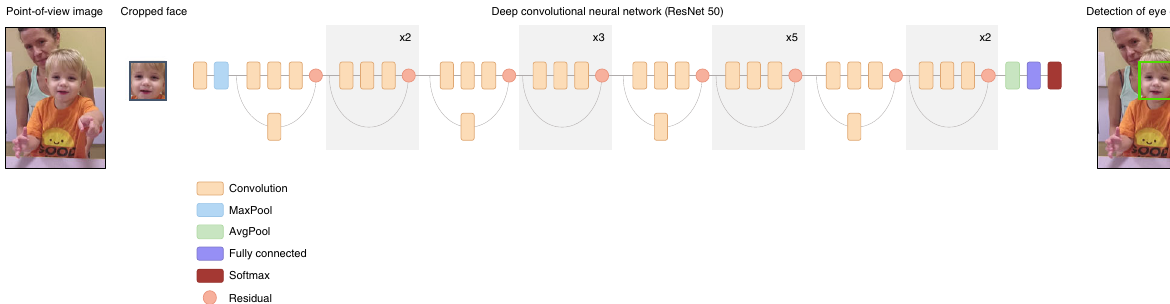
Fig. 5 Deep neural network layout. Given a frame extracted from a point-of-view camera, the subject ’ s face is automatically detected and cropped as an input to the deep neural networks. A deep neural network is used to compute the features from facial image via a series of convolutions. At the end of the network, features are combined through average pooling and fully connected layers, and the softmax operation produces the fi nal eye contact score. Using this score, algorithm can decide if the input face is an eye contact. The authors have obtained consent to publish the sample picture from the study